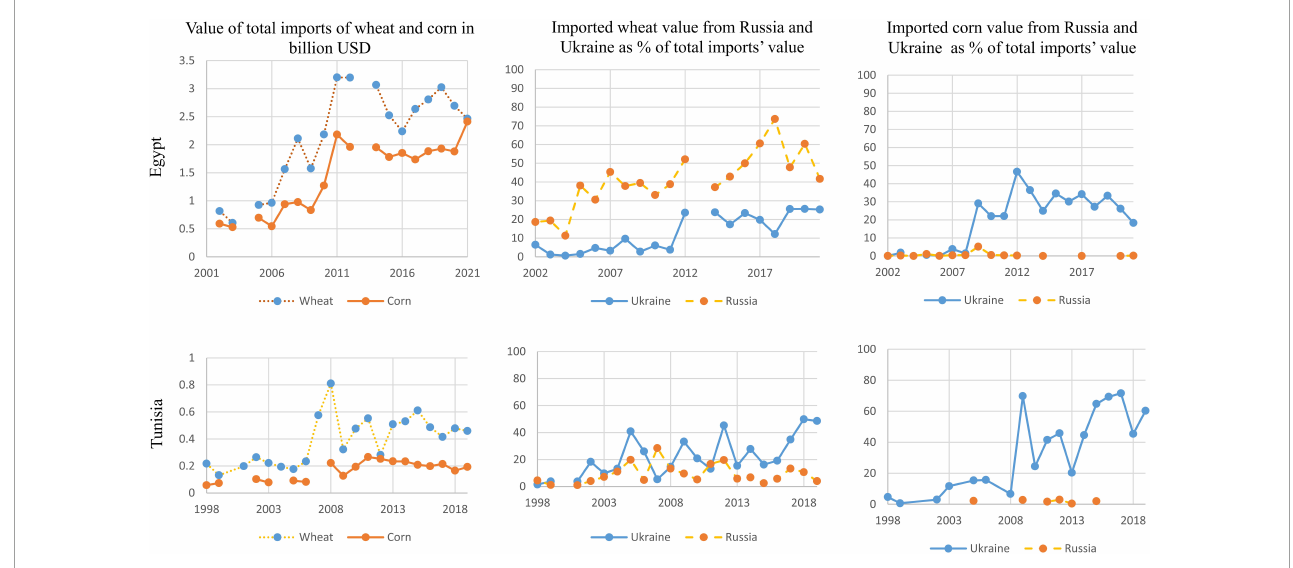
FIGURE1 Imports to Tunisia and Egypt of wheat and corn from Russia and Ukraine [Data from UN Comtrade database for the commodity codes 1,001 “Wheat and meslin” and 1,005 “Maize” (corn)].